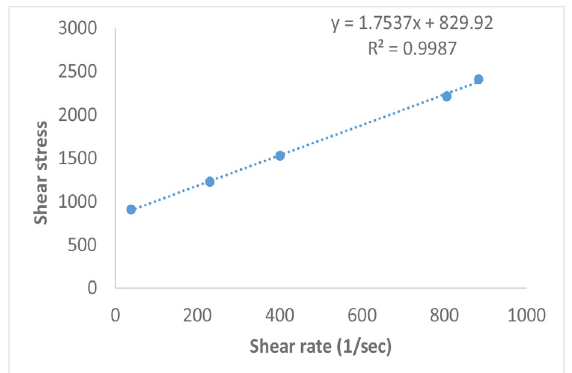
Fig. 7. Profile viscosity glycerol sample F3: Containing glycerin and